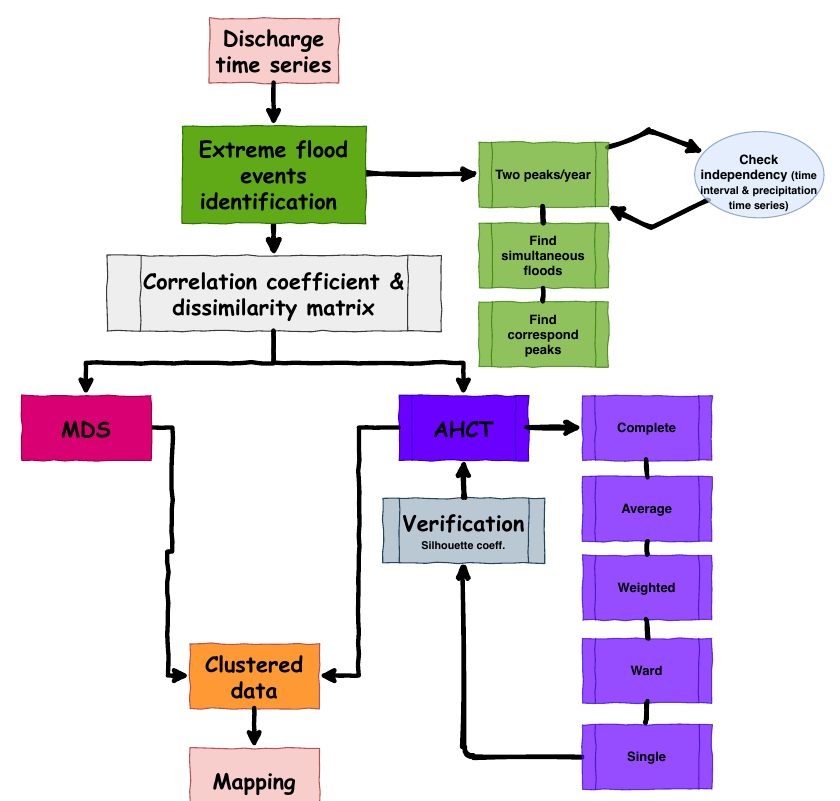
Figure 3. The flow diagram of clustering simultaneous occurrence of extreme flood